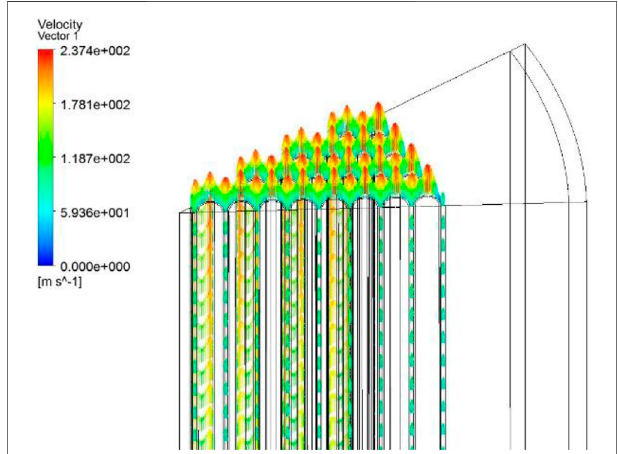
FIGURE 13 | Velocity vector of helium.